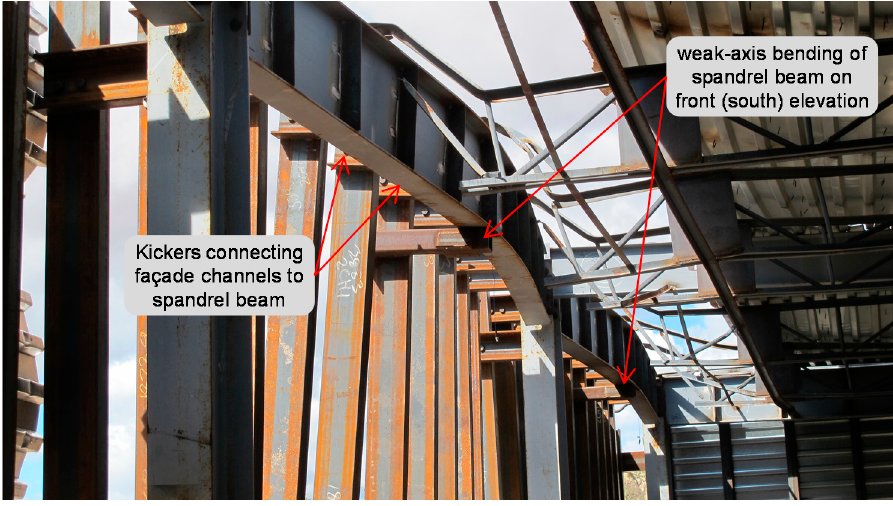
Figure 22. Test 2—View from 3rd floor looking at the bent spandrel beams of roof.